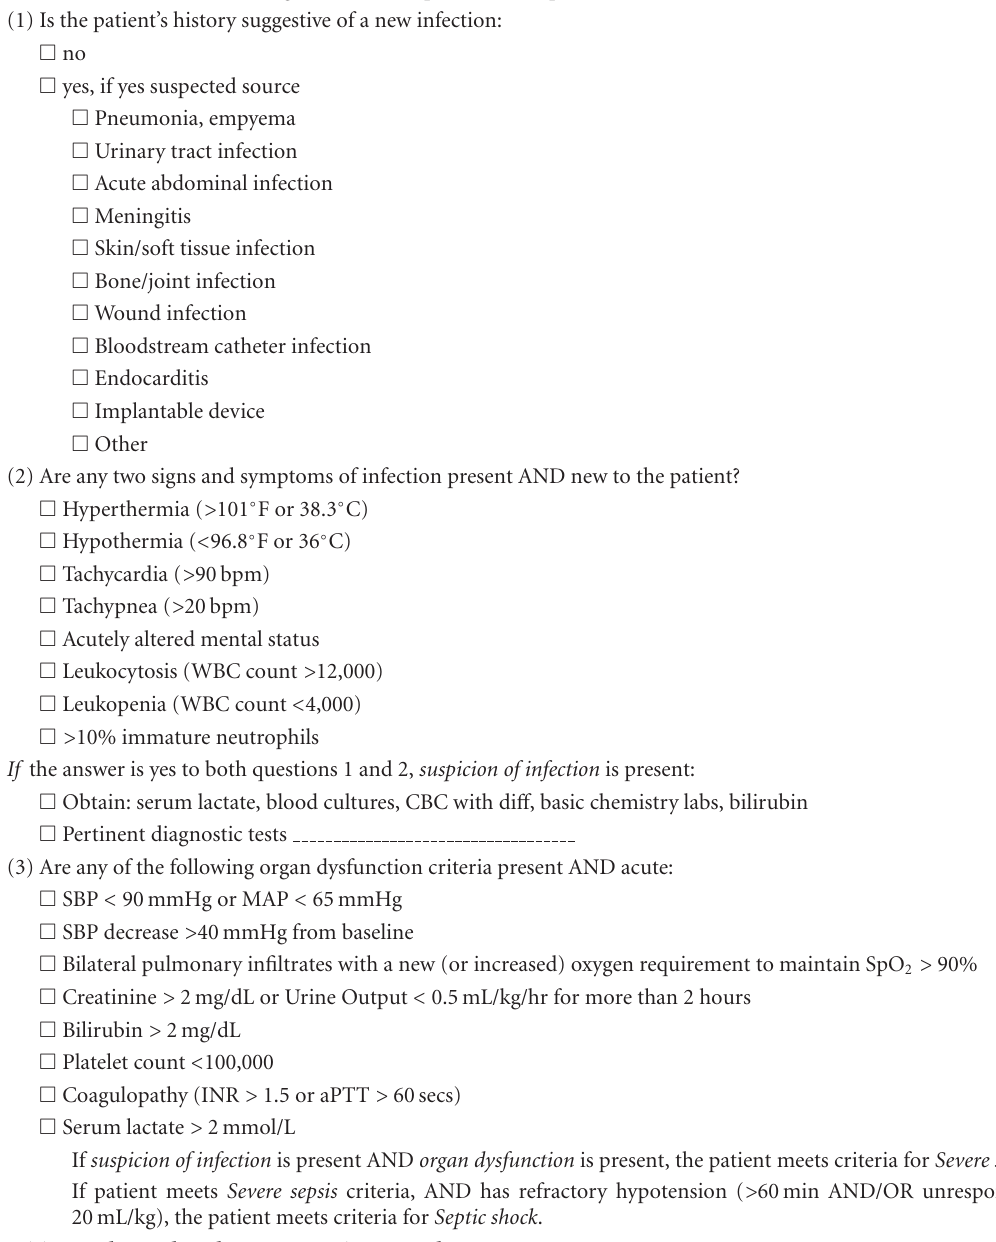
Table 7: Evaluation for sepsis—screening